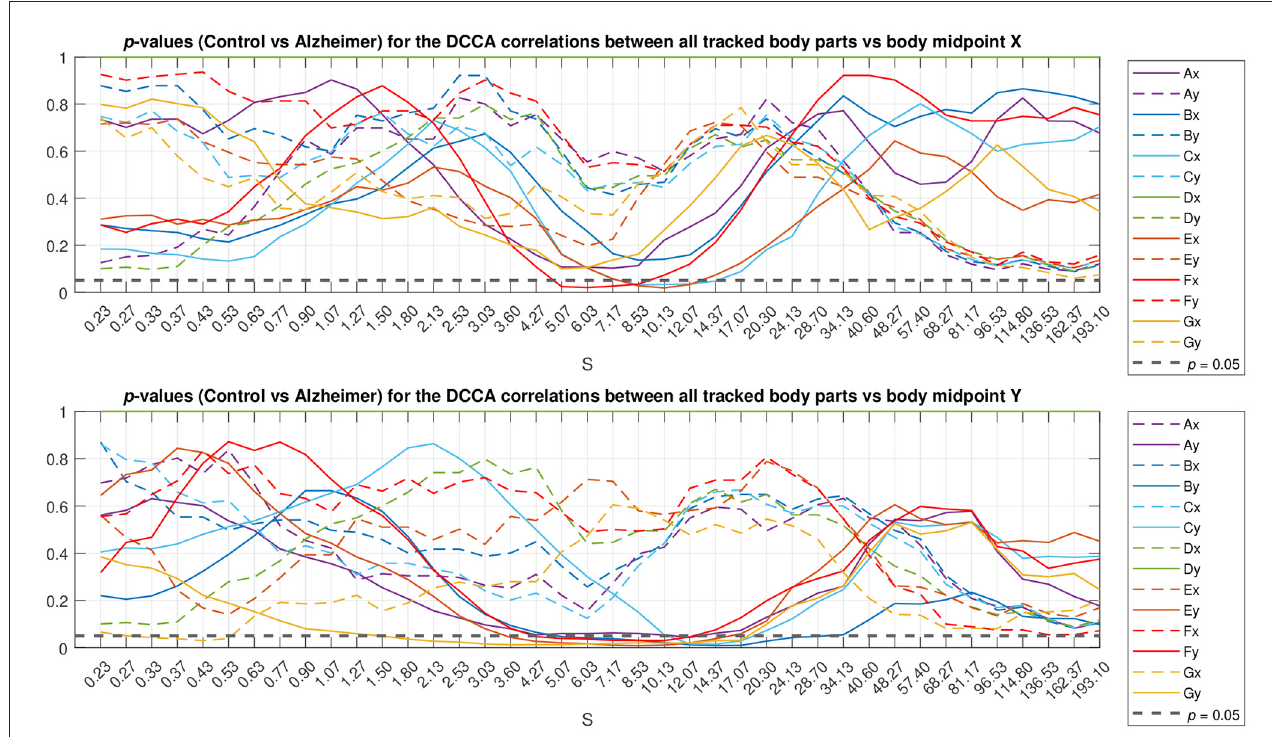
FIGURE5 Scale localization of discrepancies between the correlation dynamics of the same animal body parts as denoted in Figure 1 relative to the animal body midpoint as a function of scale S , expressed in terms of p -values. Full lines denote specific relations corresponding to the same Cartesian coordinate (movements either along the X-axis in the upper panel or along the Y-axis in the lower panel), while dashed lines denote unspecific relations (either respective body part movements along the X-axis vs. the animal midpoint movements along the Y-axis, or vice versa). The horizontal dashed black line represents p < 0.05